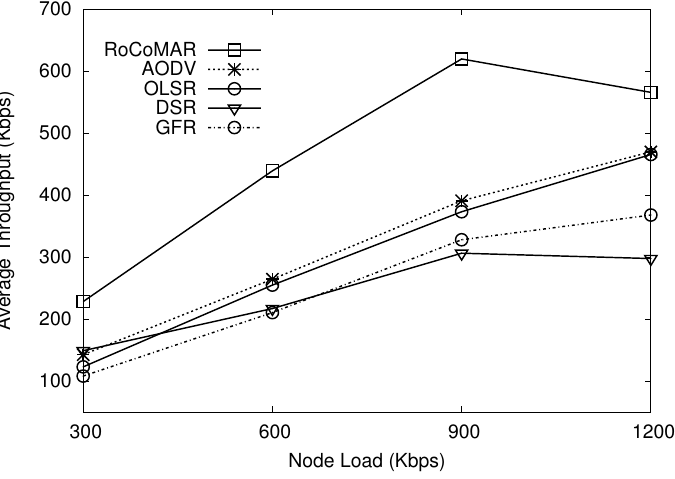
Figure 9. Effects of network traffic on average throughput.